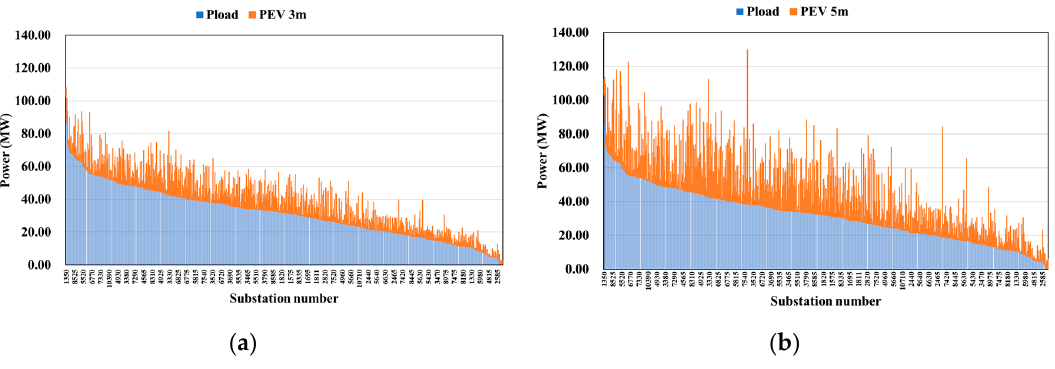
Figure 11. Charging demand and loads at the substation: ( a ) PEV 3 m; ( b ) PEV 5 m.